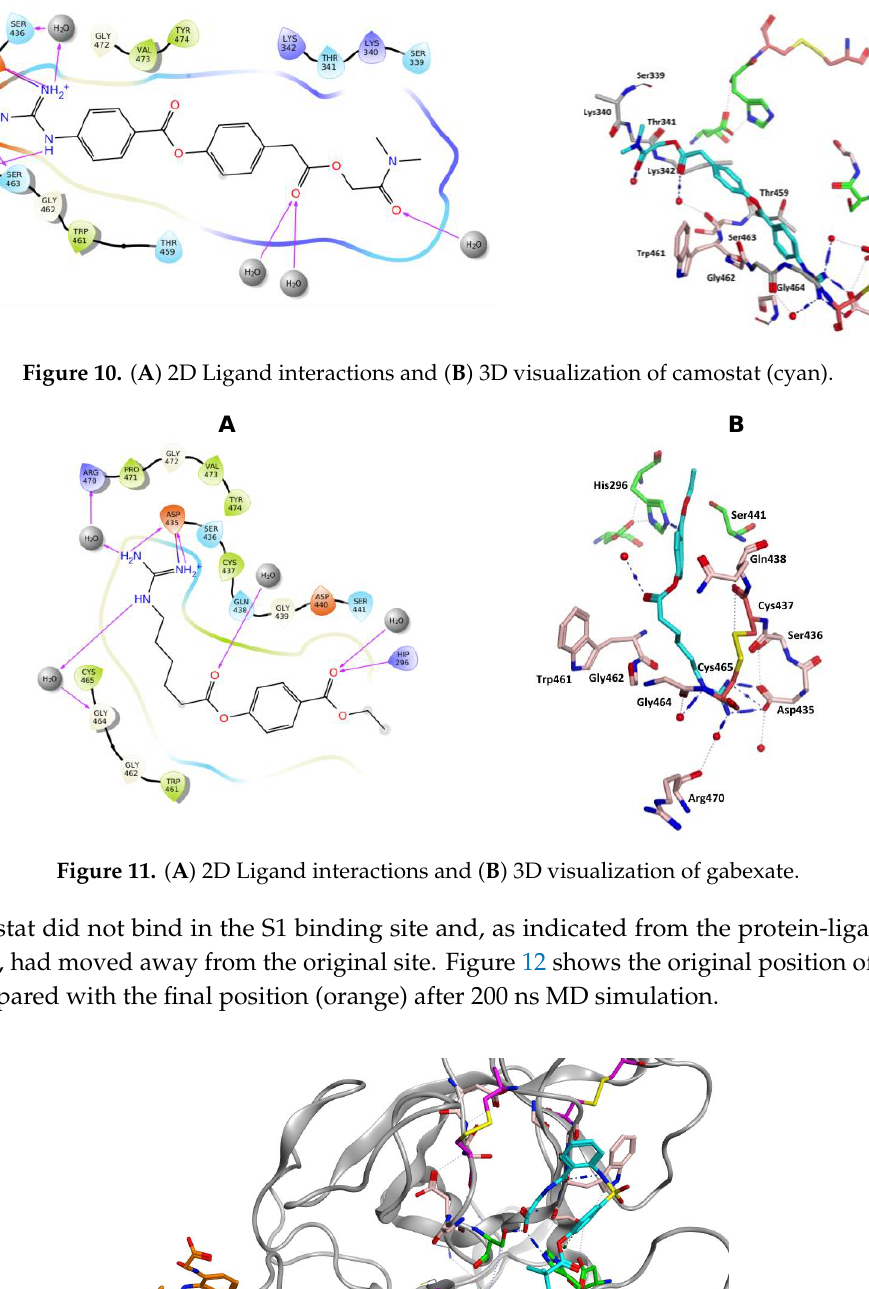
Figure 12. 3D visualization of sivelestat showing the original position (cyan) in the S1 binding pocket and after 200 ns MD simulation (orange).